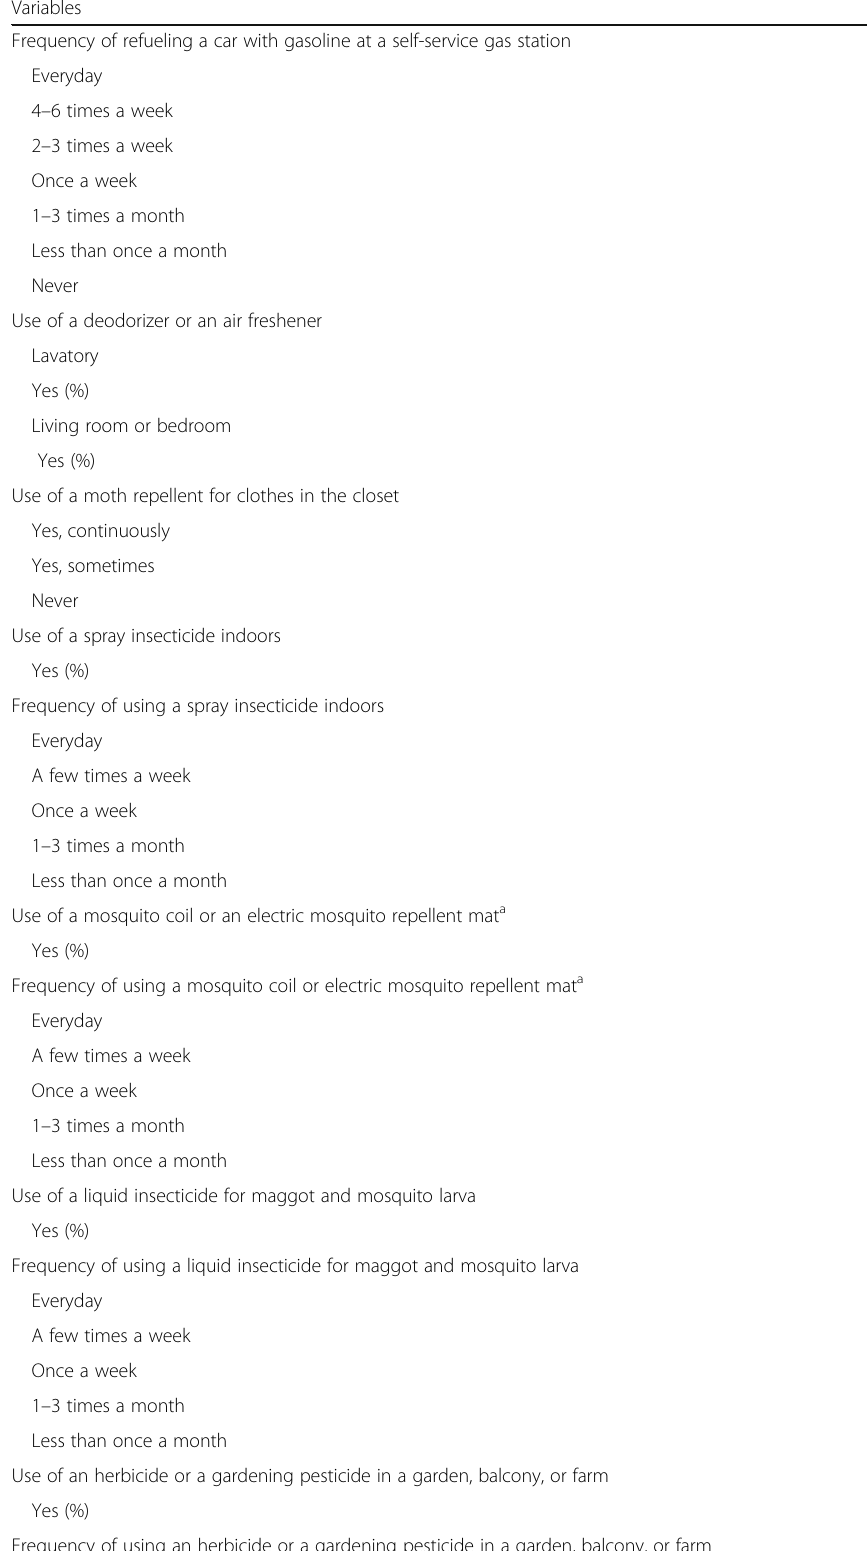
Table 6 The use of household chemicals during pregnancy